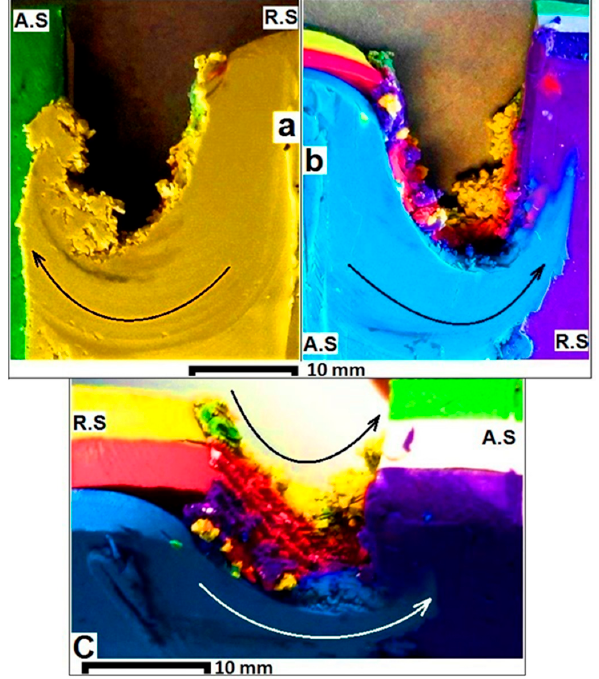
Figure 13. Analogue model of the exit zone: ( a ) Top view; ( b ) Bottom view; ( c ) End view.